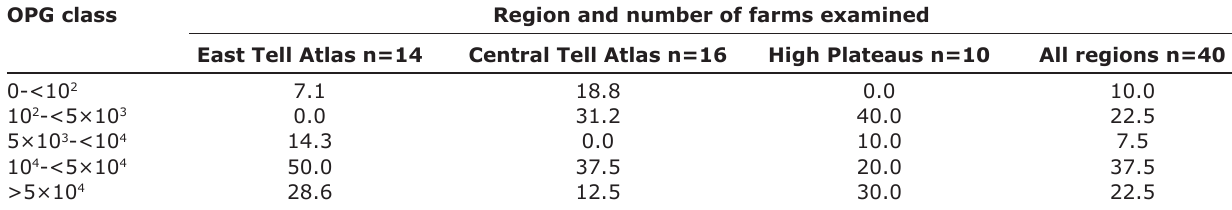
Table-2: The percentage distribution of the farms in three regions of Algeria according to the intensity of coccidian infection classes. OPG class Region and number of farms examined